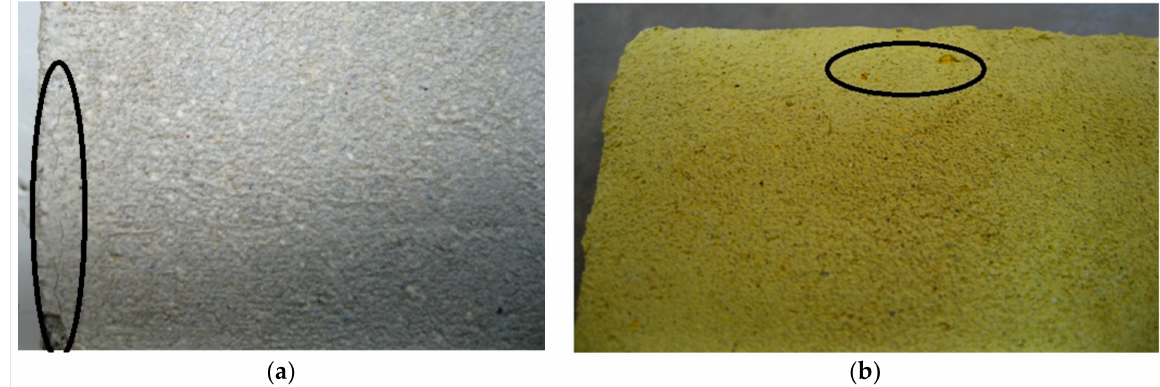
Figure 9. The appearance of the specimens after 50 test cycles: ( a ) 03D+S-3+Neolith 7200; ( b ) 03D+S-3+Neolith 7200 + 5% yellow